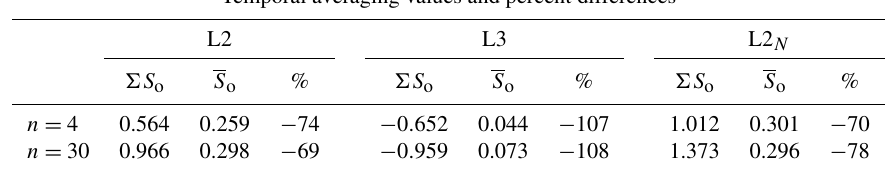
Table 1. Temporal averaging values and percent differences. (cid:54)S o refers to a simple average of the S o for individual cloudy scenes. S o refers to the S o regression fit to the temporally aggregated data from all cloudy scenes. The percent difference is defined as ( S o − (cid:54)S o ) /(cid:54)S o . n = 4 and n = 30 refer to the 800m and 6km spatial averaging scales,